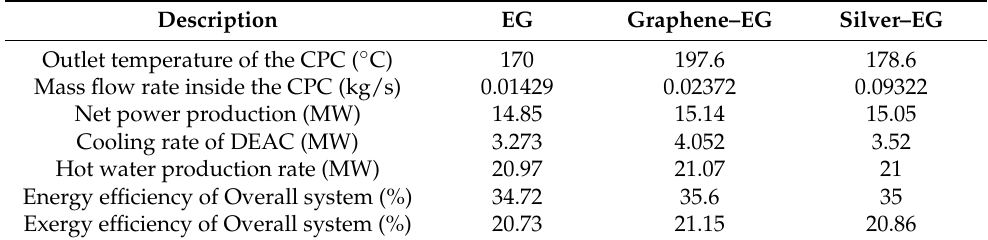
Table 9. Thermodynamic assessment results with different heat transfer fluids in CPC.